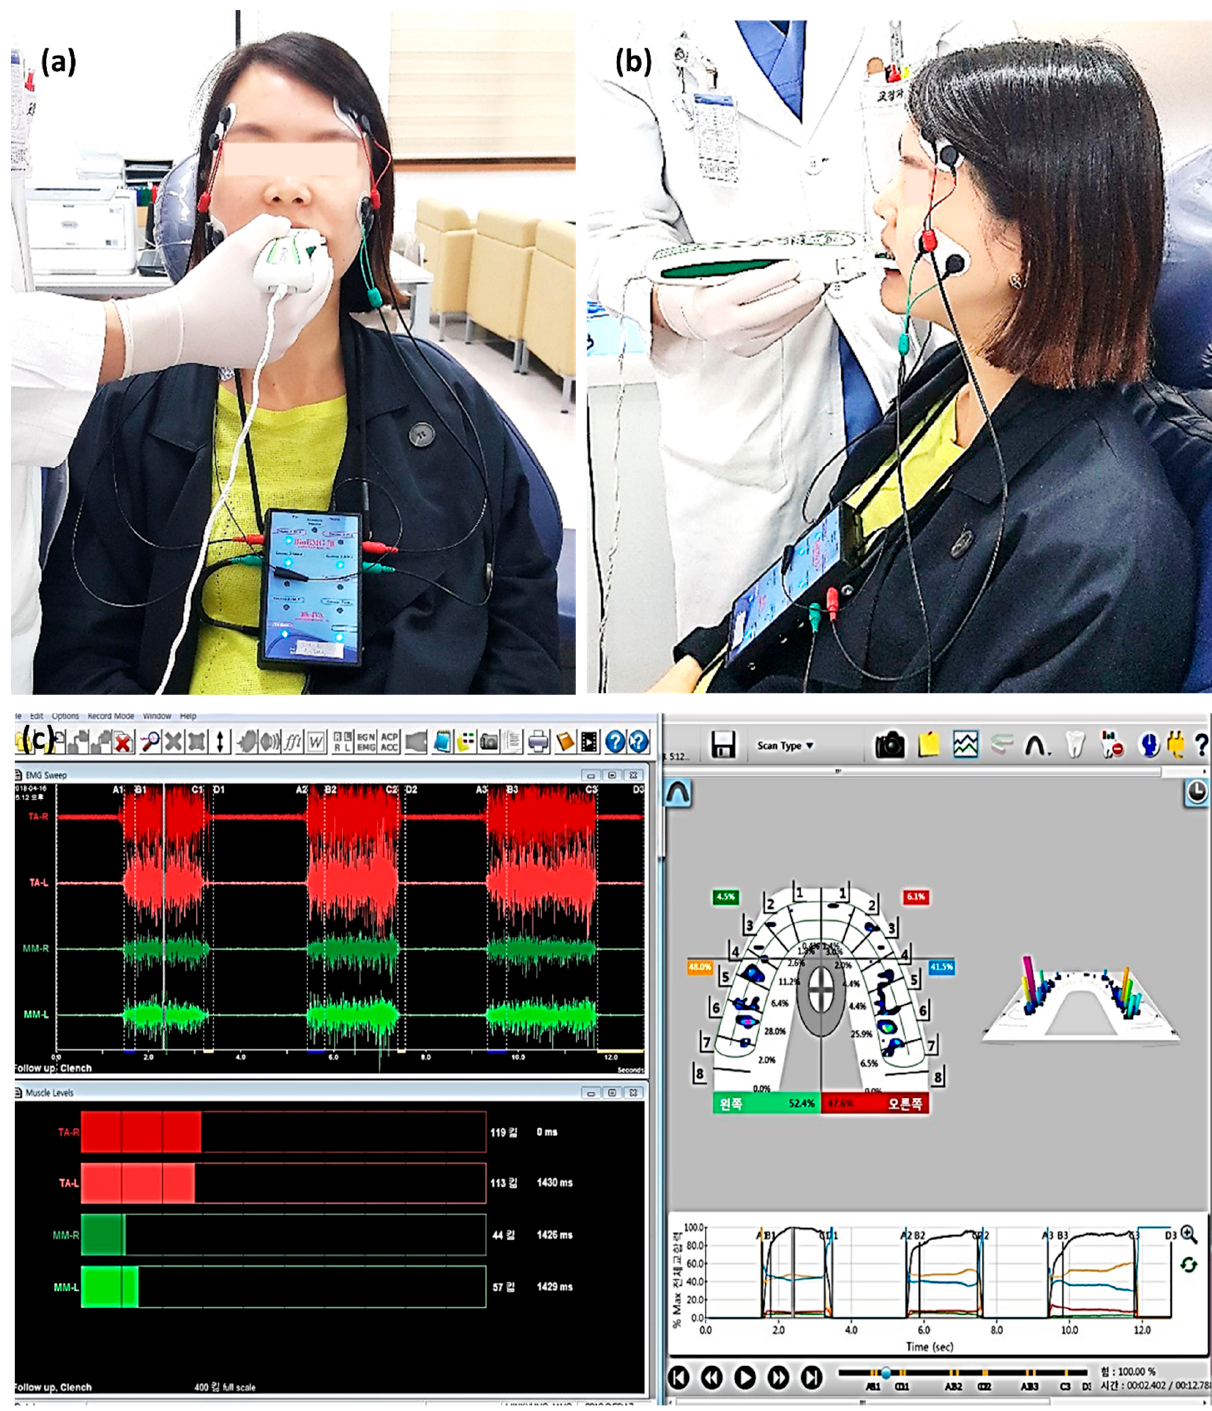
Figure 5. ( a ) T-scan system (Tekscan Inc., South Boston, MA, USA) and electromyography (EMG) recording device (BioEMG III TM , BioResearch Inc., Milwaukee, WI, USA) application to a patient. The patient sits in an upright position and bilateral electrodes are placed on the temporalis anterior (TA) and masseter (MM) muscles, simultaneously with the biting T-scan sensor. ( b ) The position of electrodes attached to the TA and MM muscles is shown on the side view. ( c ) Computer display of the occlusal force and muscle activity at maximal intercuspal position (MICP).